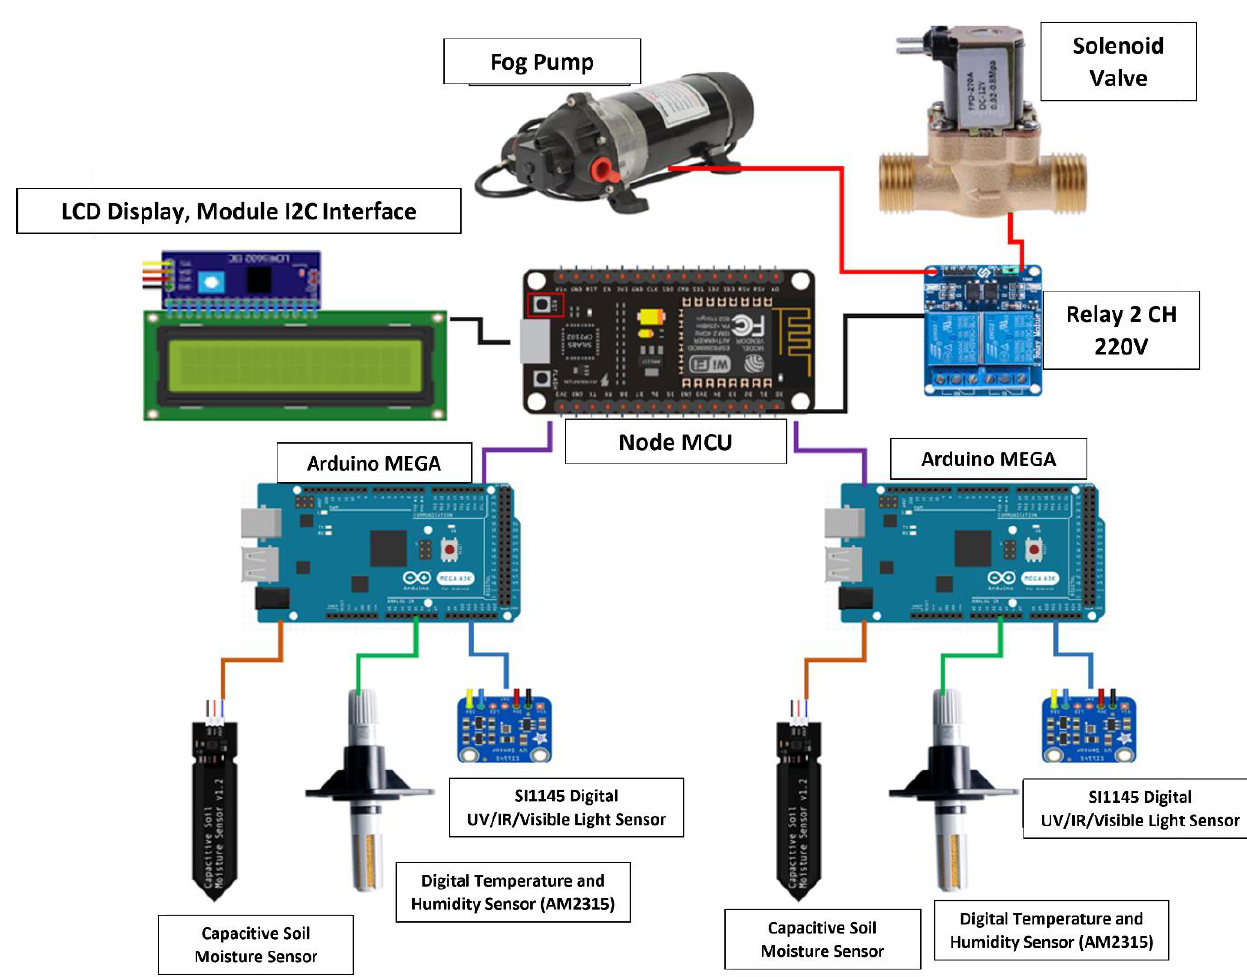
Figure 3. Schematic diagram of IoT system equipped with Light Intensity Sensor (SI1145 Digital UV/IR/Visible Light Sensor), Digital Temperature and Humidity Sensor (AM2315), Capacitive Soil Moisture Sensor with automated irrigation system.